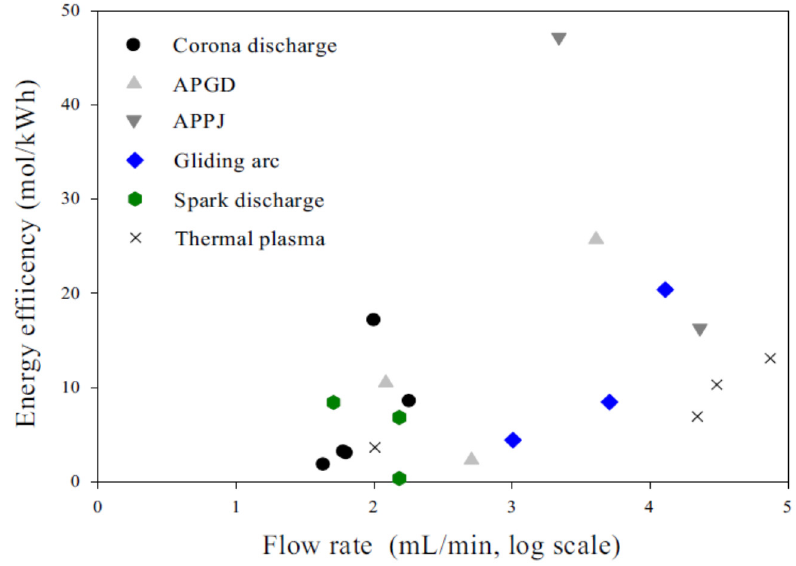
Figure 1. The energy efficiency (EE) as a function of flow rate in warm plasma. Reproduced with permission from [41]. Copyright 2020, Elsevier.